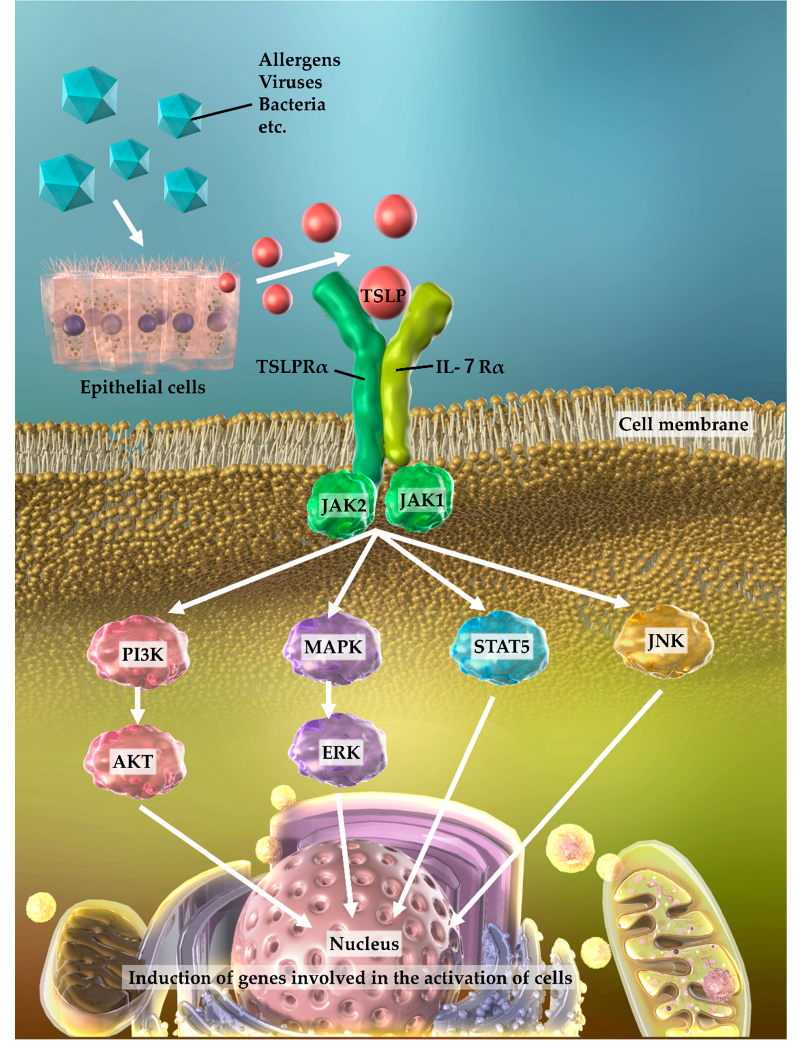
Figure 1. Thymic stromal lymphopoietin (TSLP) production, receptor structure, and intracellular signaling. TSLPs are produced by airway epithelial cells upon exposure to environmental agents, such as allergens and viruses. TSLPs bind to TSLP receptors (heterodimers comprising a TSLP receptor [TSLPR] and an IL-7R alpha [IL-7R α ] chain) expressed on dendritic cells and activate signal transducer and activator of transcription (STAT), mitogen-activated protein kinase (MAPK), phosphatidylinositol-3 kinase (PI3K), c-Jun-N-terminal kinases (JNK), and downstream signaling factors. They are involved in the expression of genes that induce the activation of cells, resulting in various types of airway inflammation and contributing to their chronicity and severity; JAK, Janus kinase; AKT, Ak strain transforming; ERK, extracellular signal-regulated